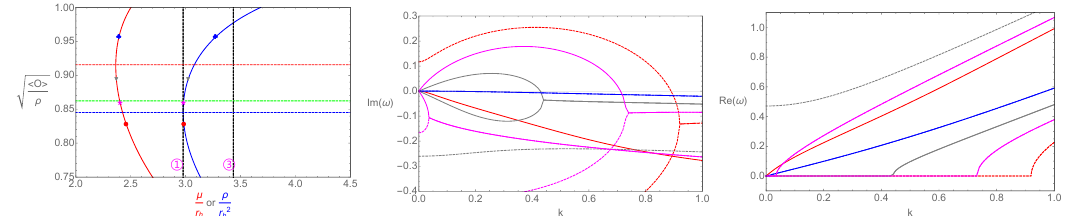
Figure 13 . Quasinormal modes at finite wave-vector for the case of 1st order phase transition. The parameters of the potential are chosen as λ = − 2 and τ = 0 . 8 . Left : blue and red solid lines are the condensate in the ρ and µ ensemble respectively. The blue and red dashed lines indicate the location of the turning points. The green dashed line indicates the point where the two modes collide with each other as displayed in figure 12. The two dashed black vertical lines marked by ‹ and fi show the positions for the turning point and the phase transition point, respectively, in the canonical ensemble as in figure 7. Middle : the imaginary part of the lowest QNMs. Each color corresponds to the points shown in the left panel and the different types of line to the different quasi normal modes. Right : the corresponding real part. Only the positive branch is shown. In both panels, the dashed lines indicate the amplitude mode and the solid ones the pair of sound